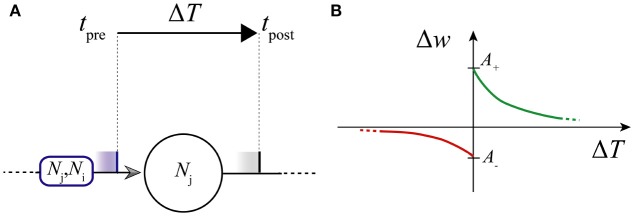
Scheme of STDP. (A) ΔT; (B) Learning window: LTD and LTP curves (in red and green, respectively).